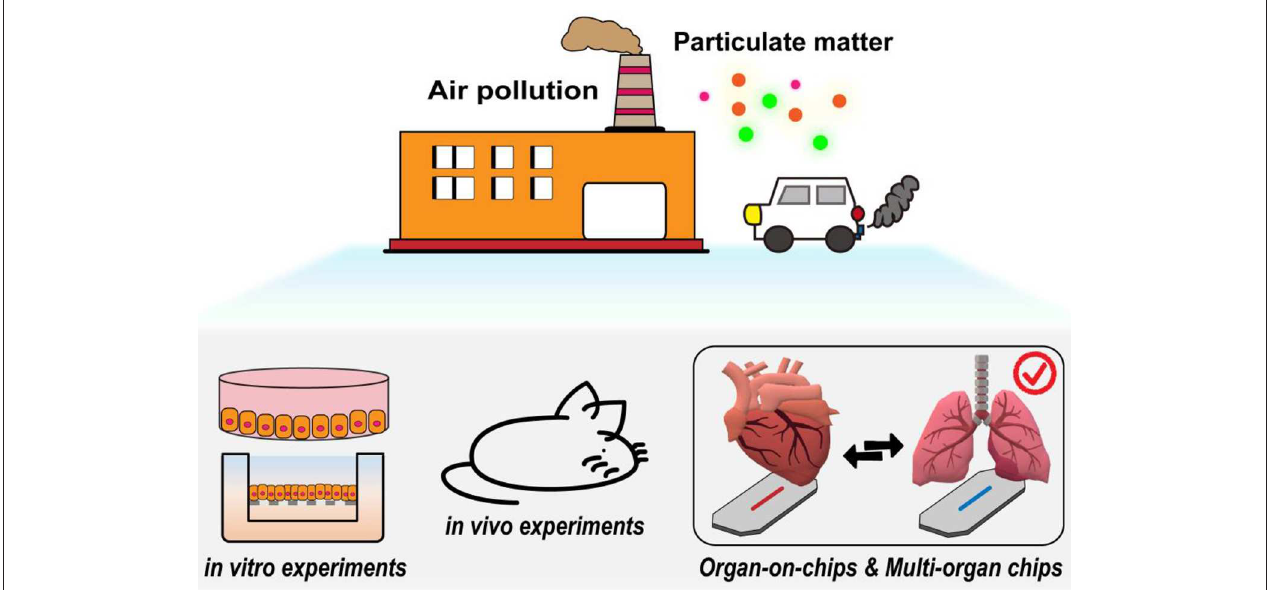
FIGURE 5 | The potential value of organ-on-a-chip biomimetic technology for PM toxicity. Its 3D microenvironment and biomimetic circulating air/liquid dynamic environment are expected to be used for PM health assessment.